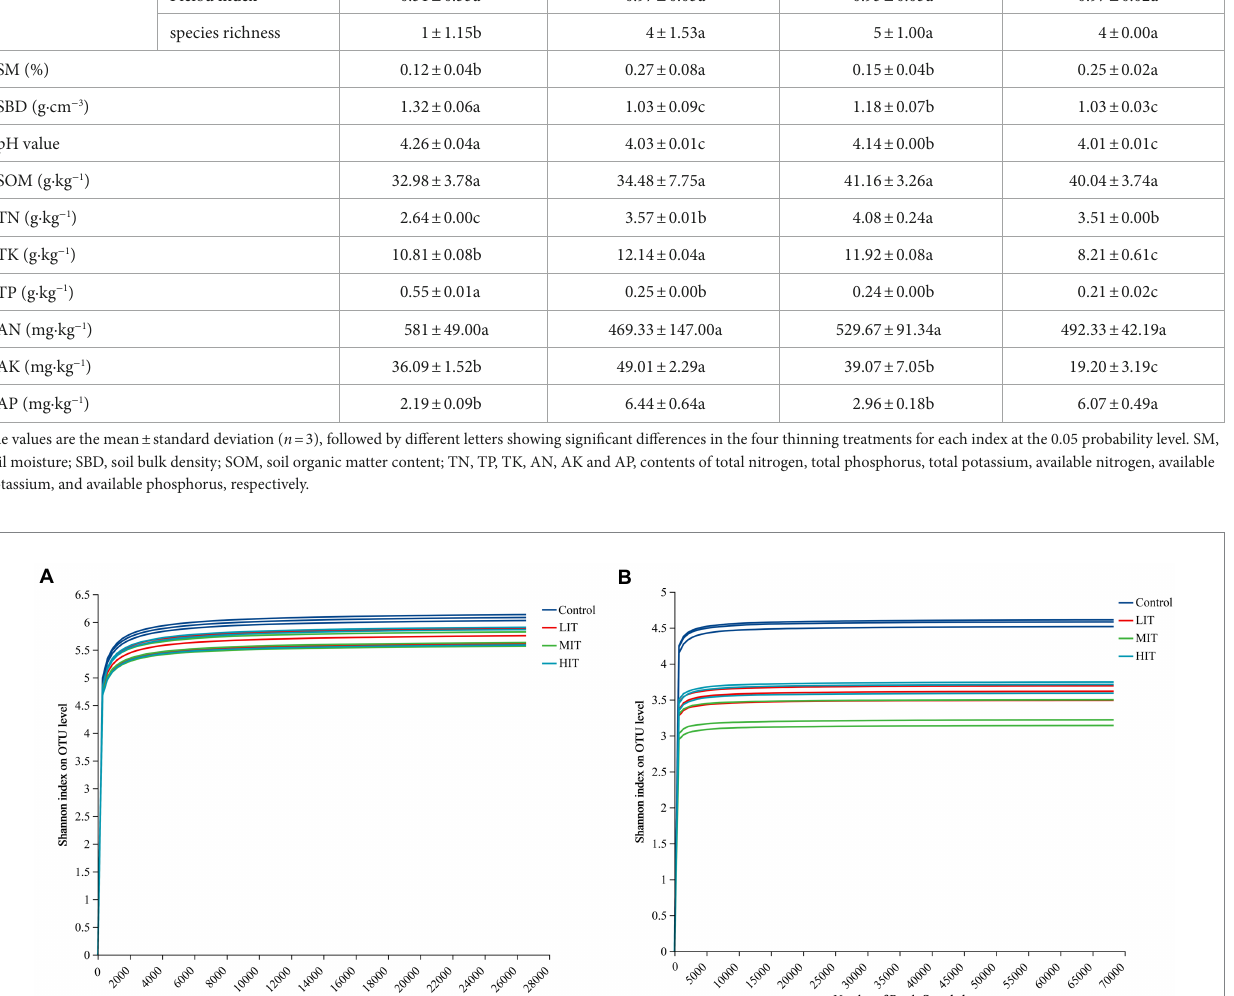
FIGURE 1 Rarefaction curve of Shannon index of bacteria (A) and fungus (B) communities at OTU level among the four thinning